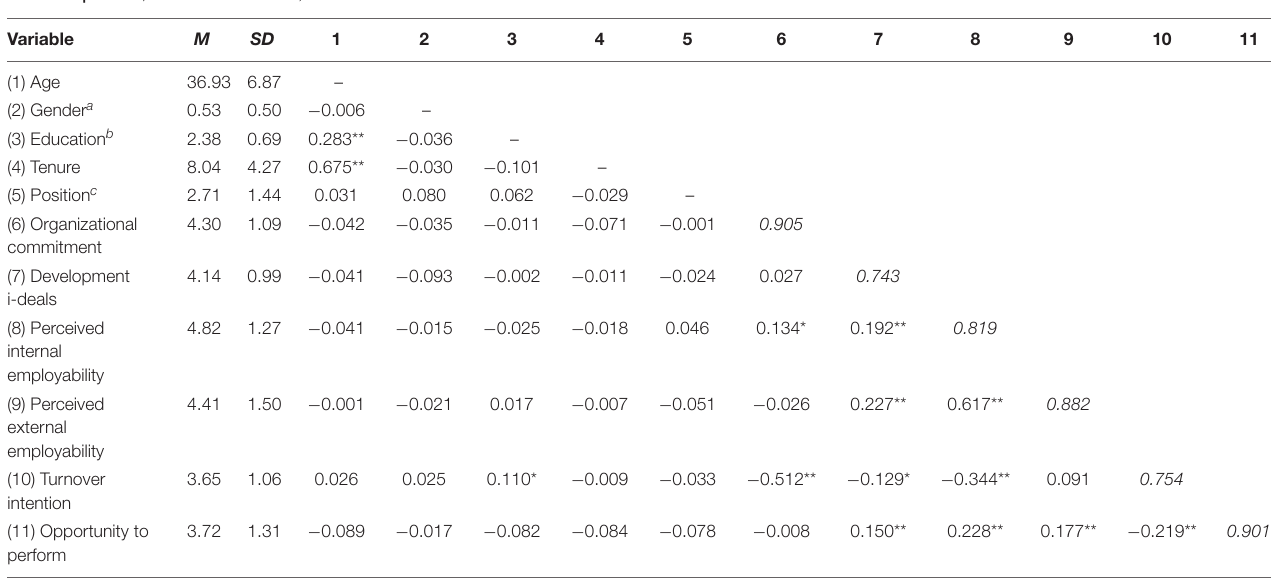
TABLE 2 | Means, standard deviations, and